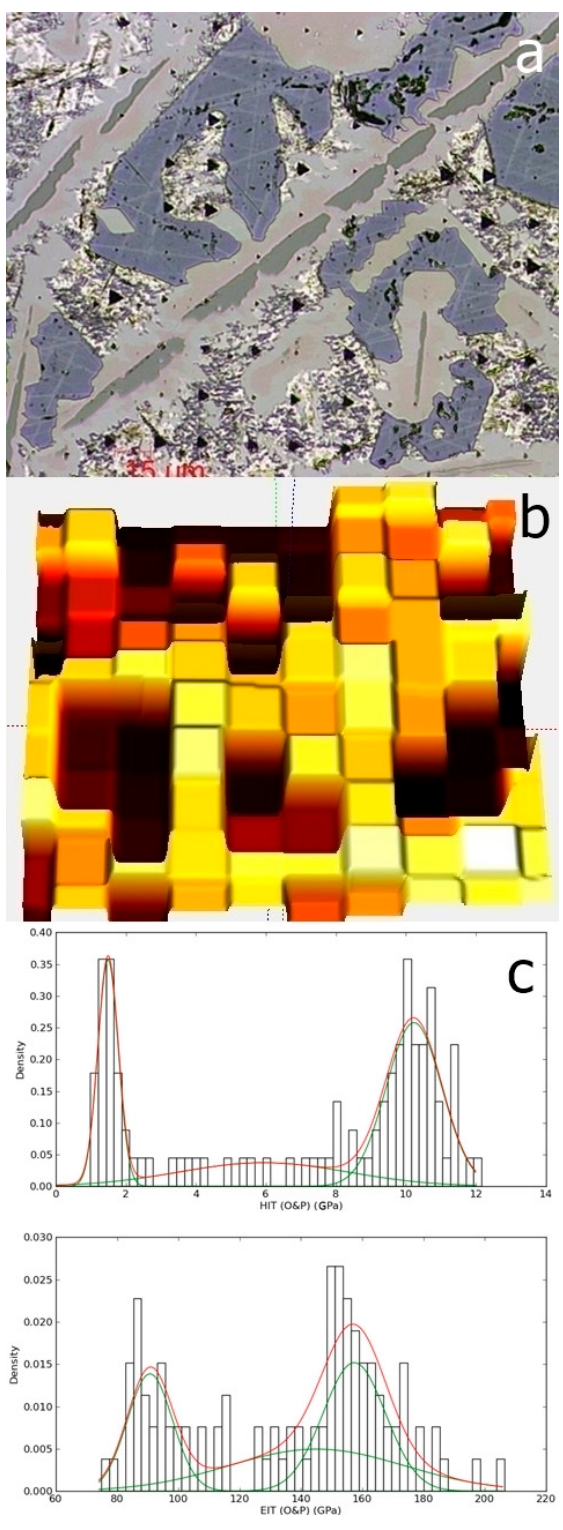
Figure 13. The indentation matrix ( a ) and the surface mapping as function of hardness ( b ); the hardness and elastic modulus distribution ( c ), extracted from the surface mapping, for the Al 67 Si 18 Ni 15 alloy.